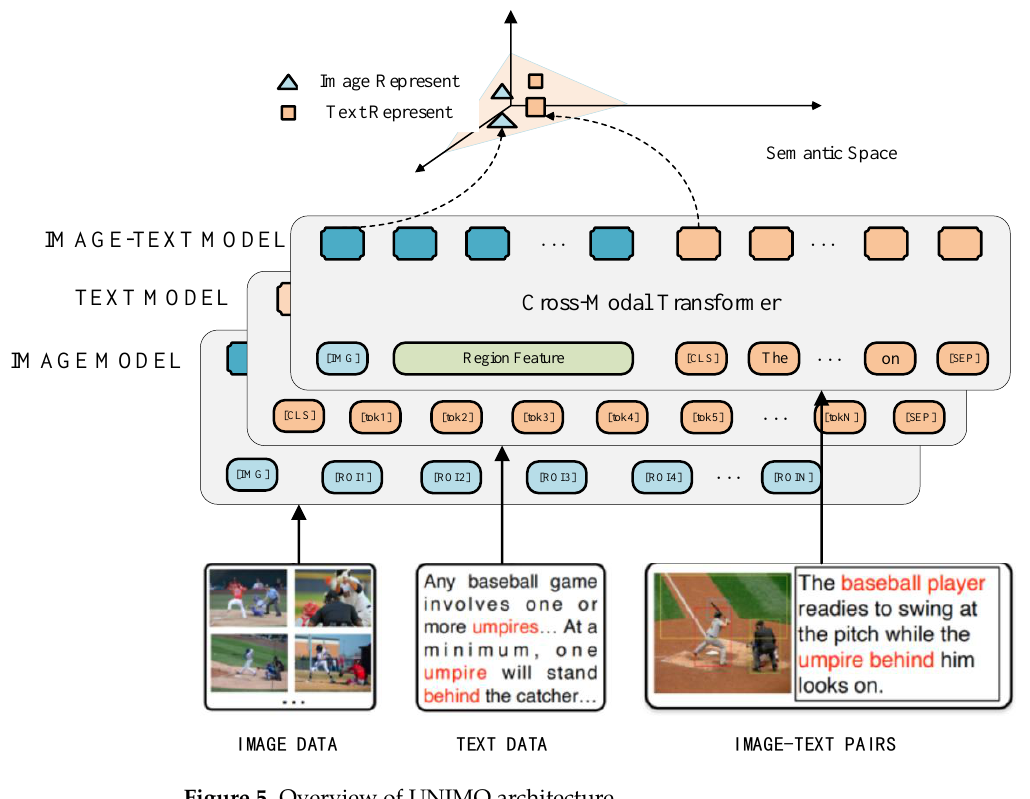
Figure 5. Overview of UNIMO architecture.